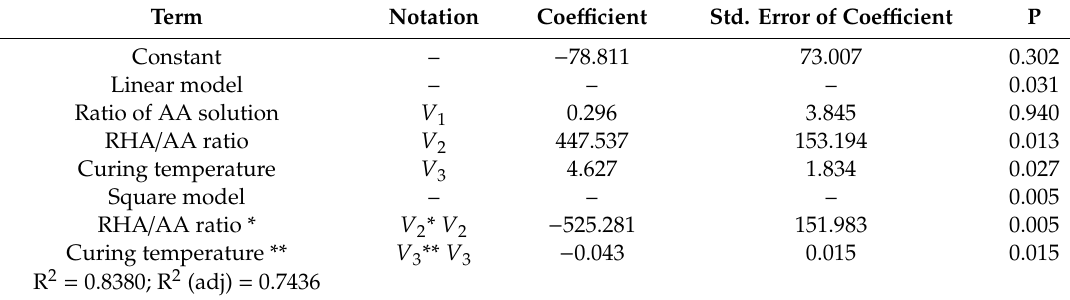
Table 7. Estimated e ff ects and coe ffi cient for flexural